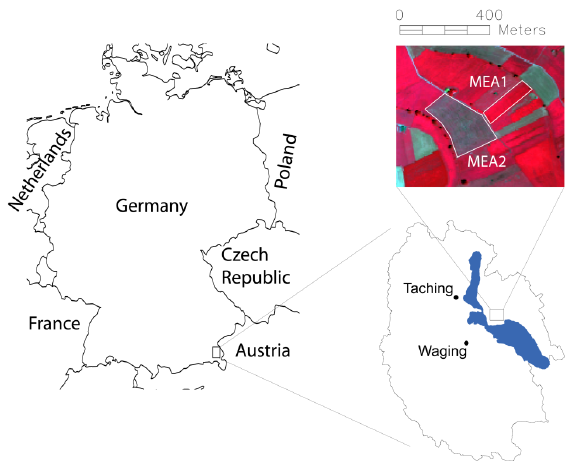
Figure 3. Location of study site within the catchment of Lake Waging-Taching in Southeast Germany. Field boundaries are superimposed on a false colour HyMap hyperspectral image recorded at June 30, 2003 (Red = band 29 (849nm); green = band 15 (646nm); blue = band 9